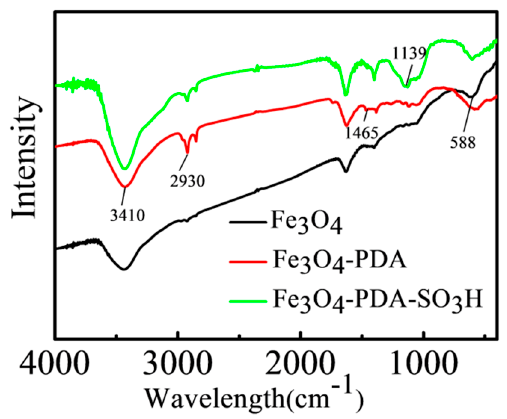
Figure 7. Infrared spectrums of the Fe 3 O 4 , Fe 3 O 4 -PDA, and Fe 3 O 4 -PDA-SO 3 H .